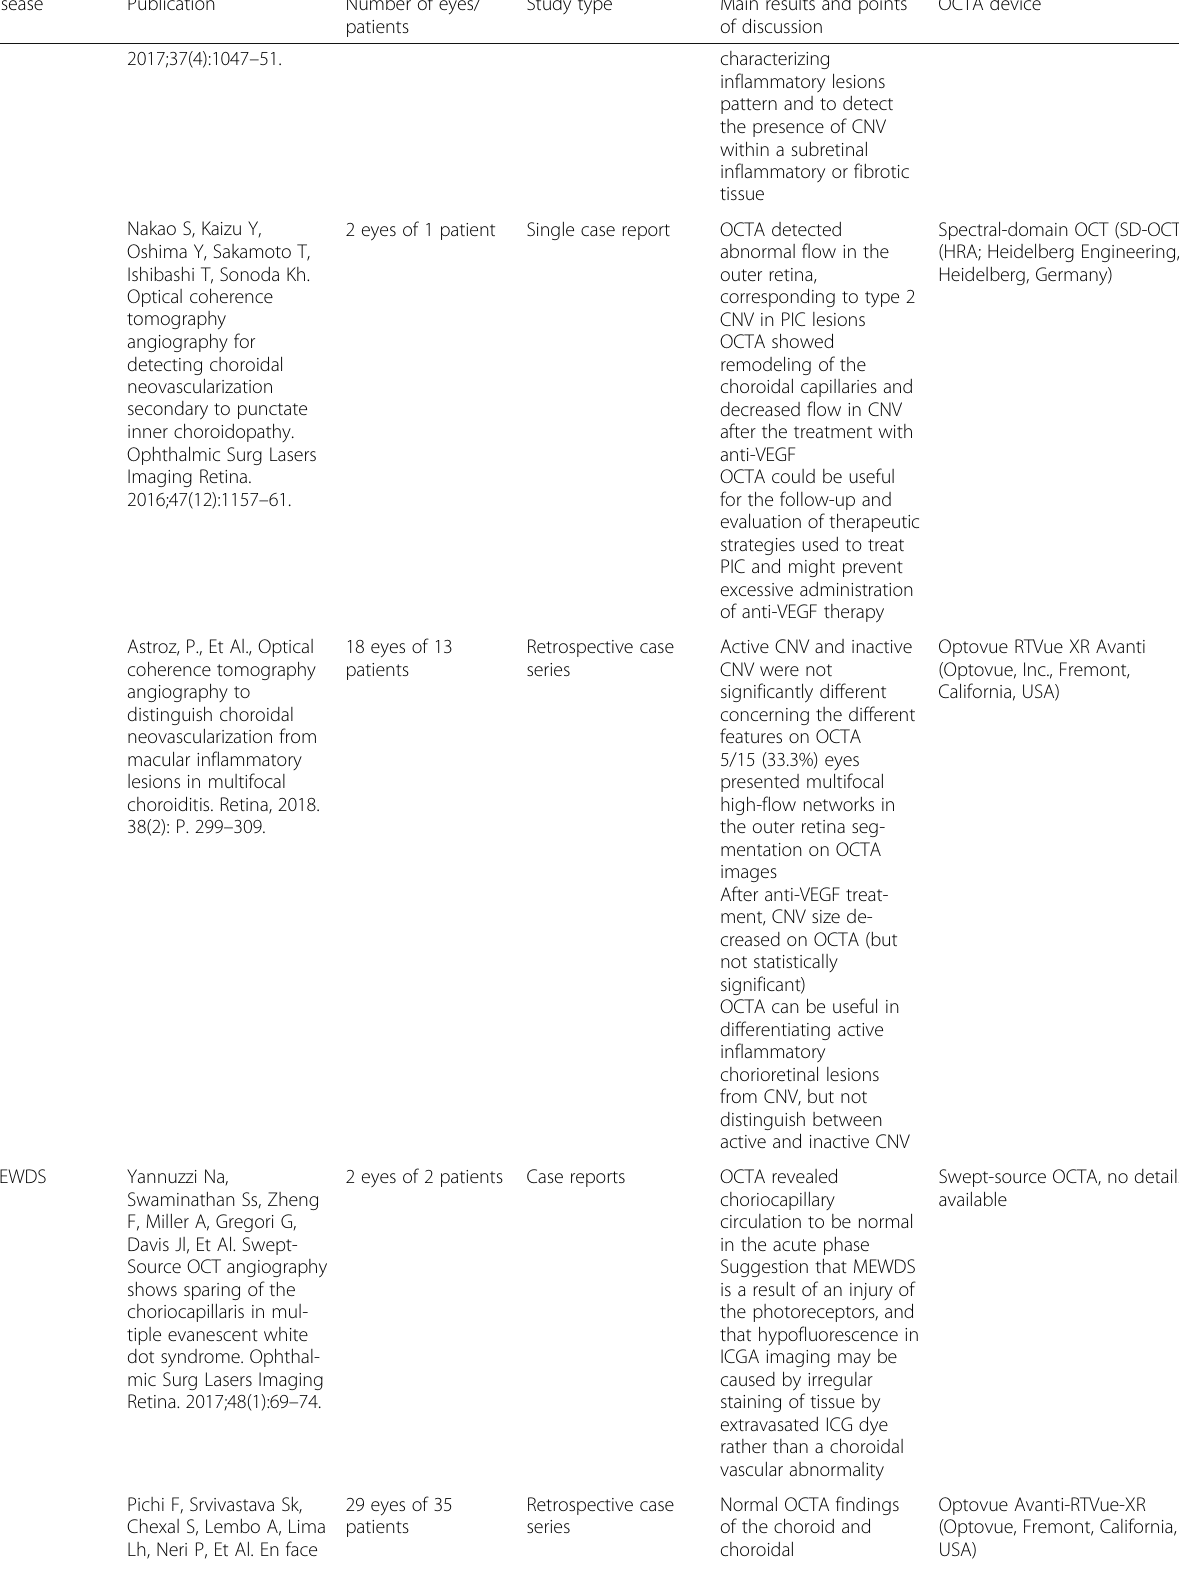
Table 1 Summary of publications on the implementation of OCTA in white dot syndromes (Continued)